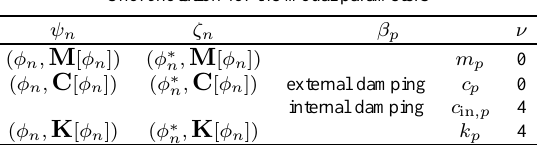
Table 1 Short notation for the modal